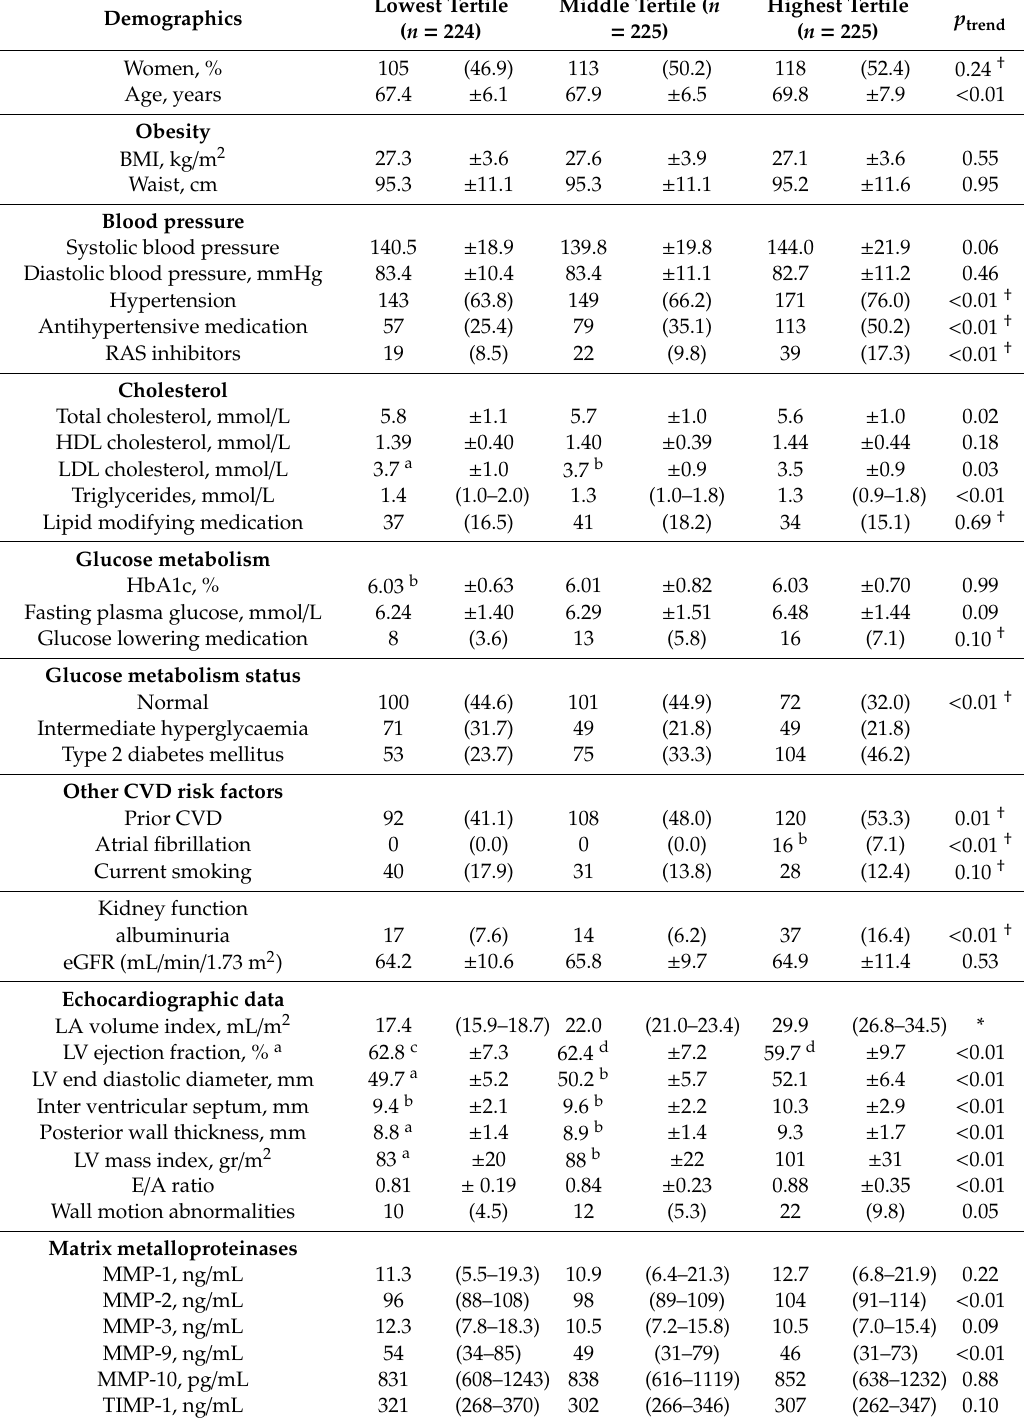
Table 1. Clinical characteristics of the study population according to tertiles of left atrial volume index ( n =